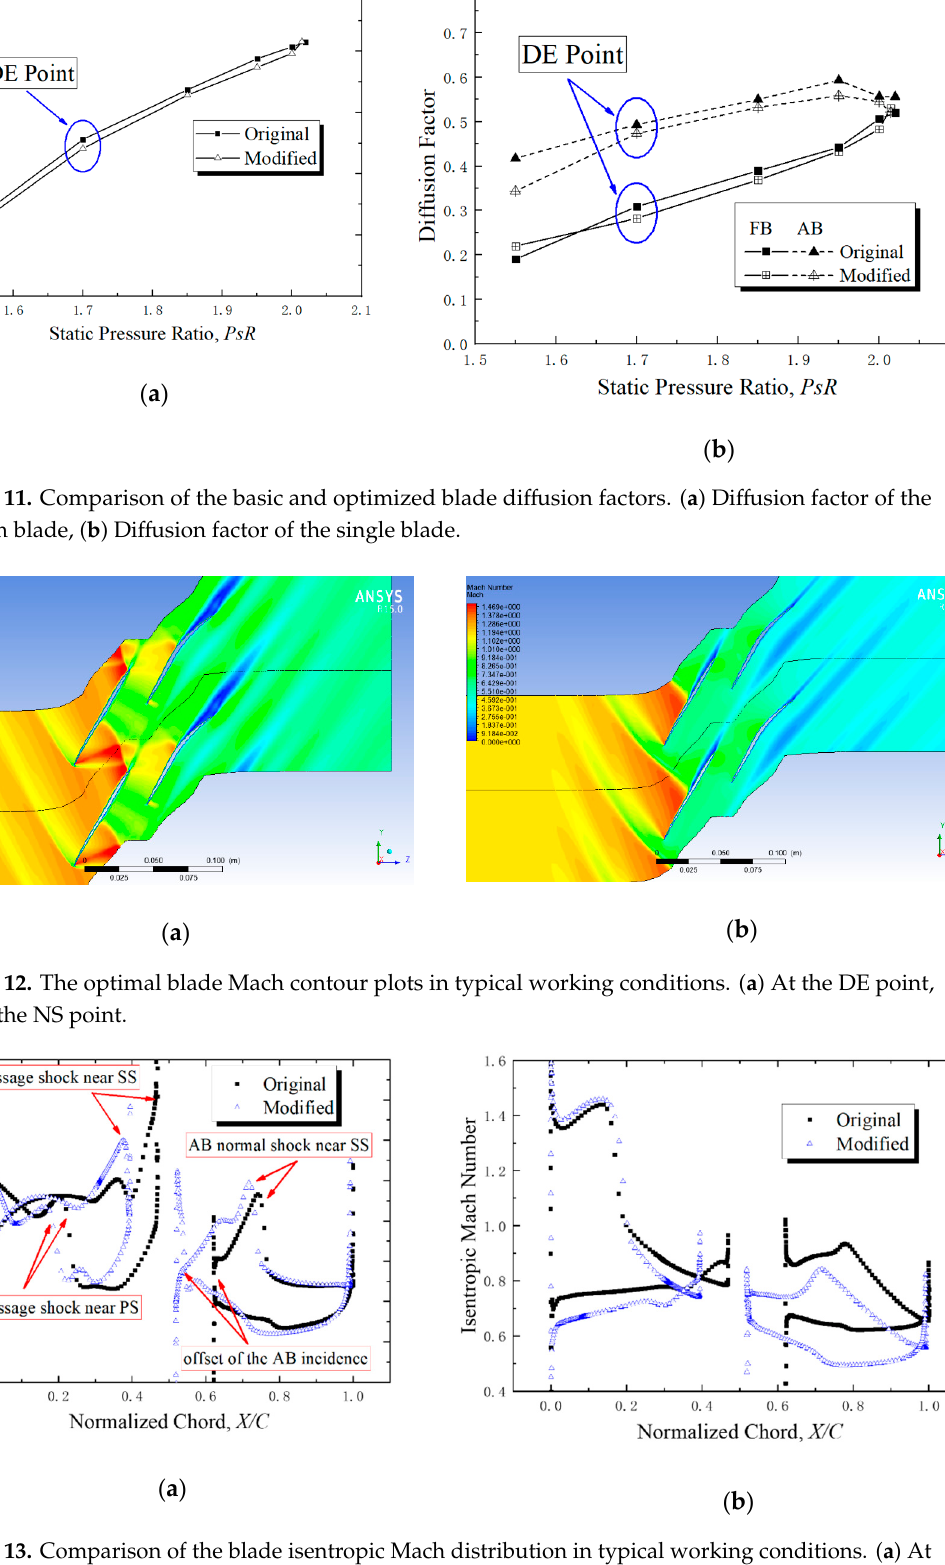
Figure 13. Comparison of the blade isentropic Mach distribution in typical working conditions. ( a ) At the DE point, ( b ) At the NS point.